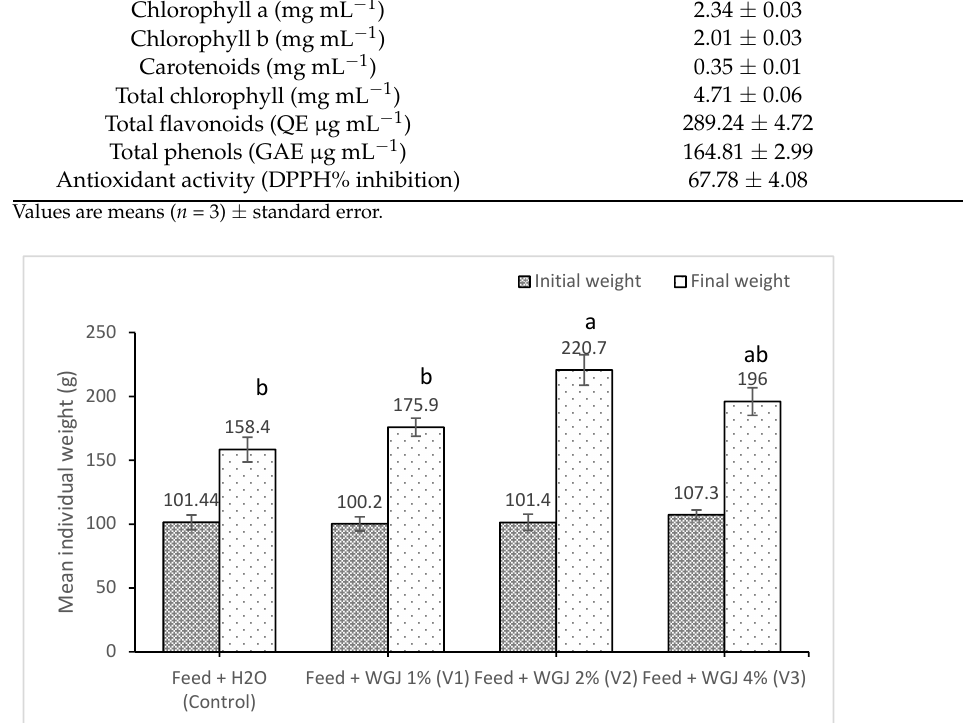
Figure 1. Initial body weight and final body weight of common carp feed four diets with different inclusion levels of wheat grass juice (WGJ). Results are means ± standard error, small letters—statistically significant differences, Tukey test ( p < 0.05).